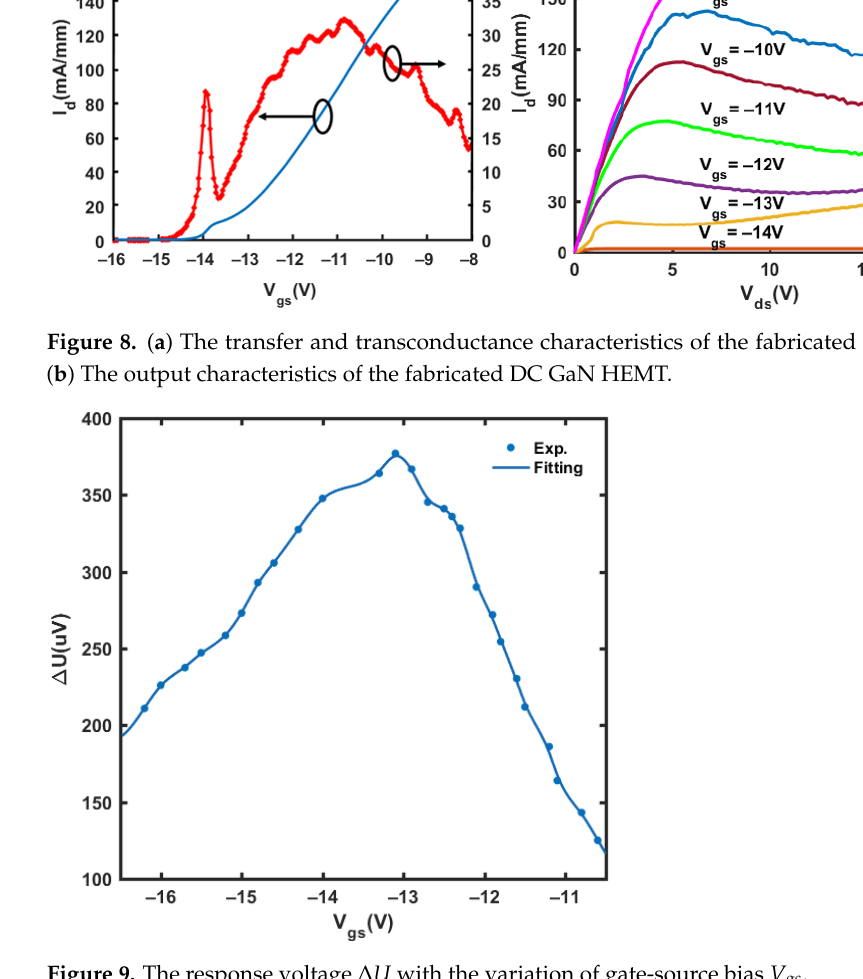
Figure 9. The response voltage ΔU with the variation of gate -source bias V gs .